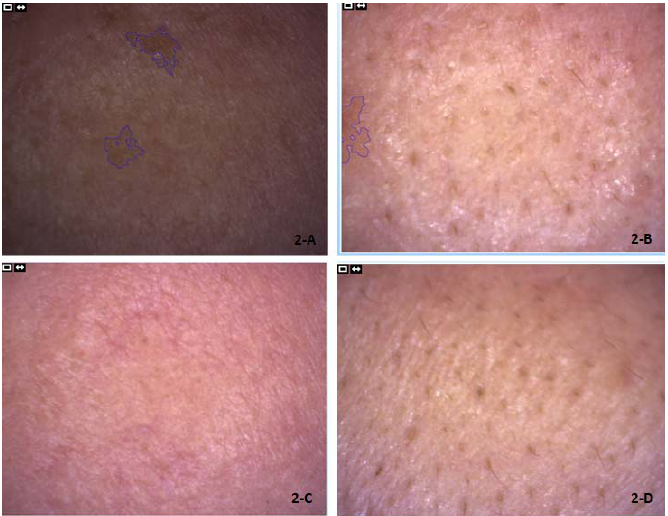
Figure 2. Graphic of typical results for the morning determination. ( 2 ‐ A ): Spot on the right cheek and ( 2 ‐ B ): Spot on the forehead, on day 0; ( 2 ‐ C ): Spots on the right cheek and ( 2 ‐ D ): Spot on the forehead on day 45, both in volunteer 4. Spots are demarcated in purple and calculated as number of dark spots in dimensionless units by the software. No spots found on figures ( 2 ‐ C ) and ( 2 ‐ D ).